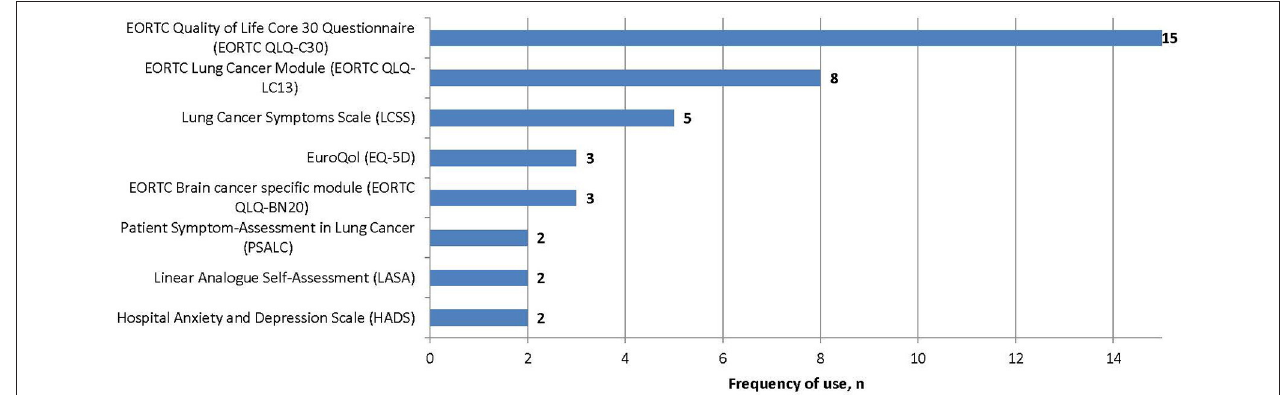
FIGURE 2 | PROs used in identified SCLC literature and frequency of